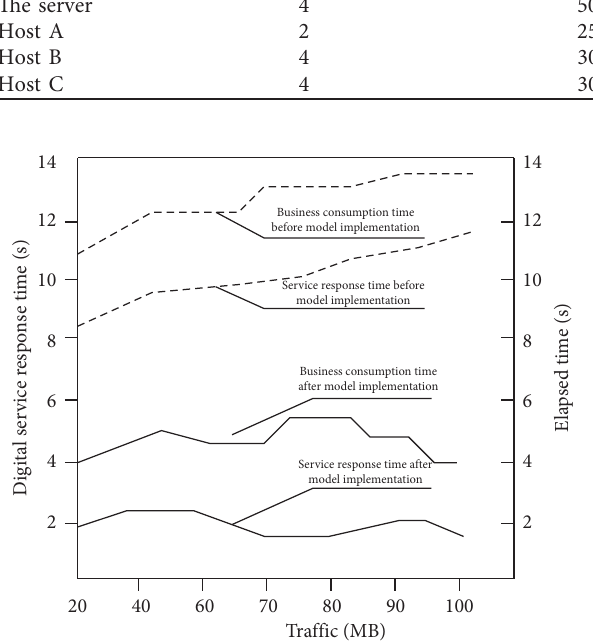
Figure 5: Implementation effect of digital service model of red education resources.